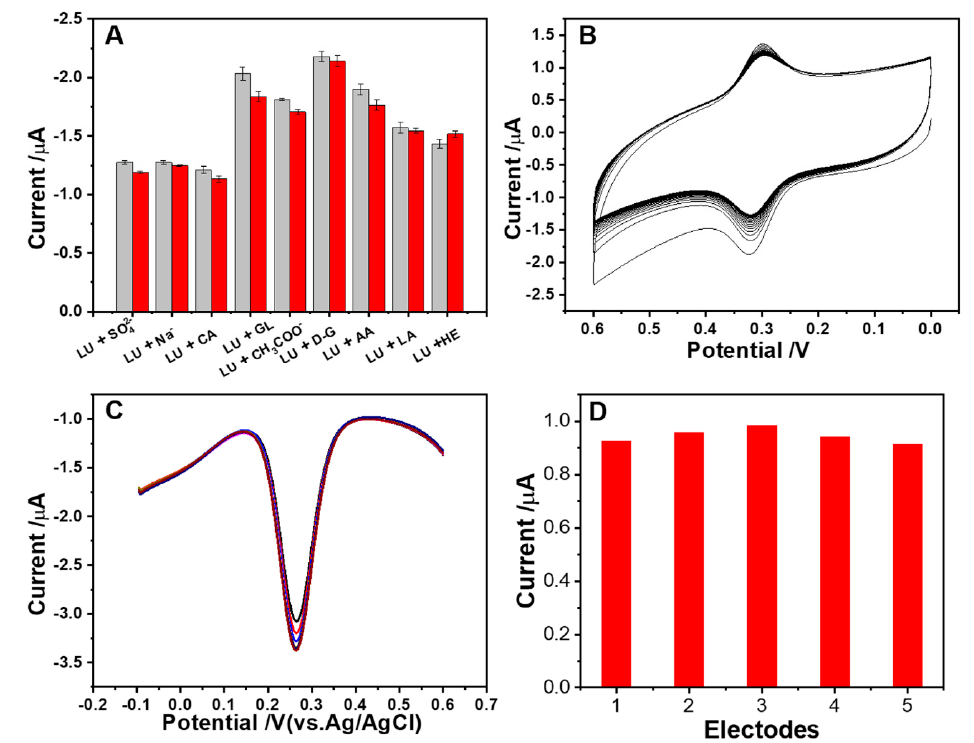
Figure 8. ( A) Anti-interference ability: different types of interfering substances caused changes in the peak current of LU detected by DPV on UiO-66 / ErGO / GCE. ( B ) Stability: CV of UiO-66 / ErGO / GCE was repeated at 20 cycles in 0.5 µ M of LU in PBS (pH 6.0), scan rate was 0.05 V s − 1 . ( C ) Repeatability: single modified electrode pair 0.5 µ M of LU intermittently measured 8 times through DPV under the same conditions. ( D ) Reproducibility: repeated measurements of 0.5 µ M of LU with multiple modified electrodes, changes in oxidation peak current.